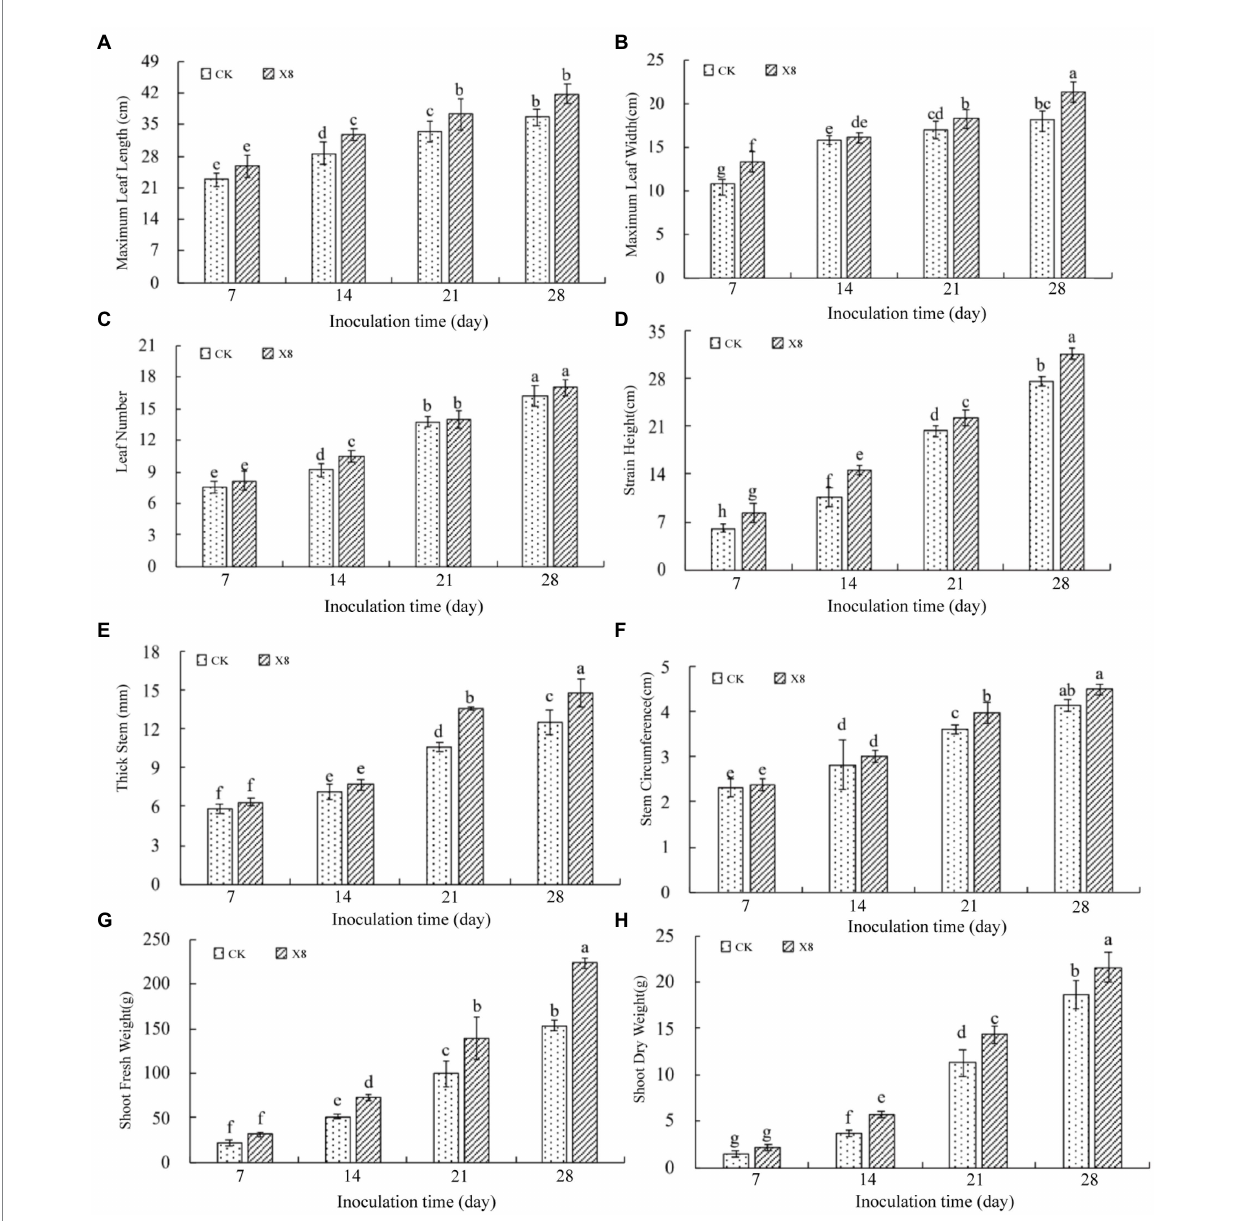
FIGURE 3 Impact of X8 on tobacco growth indicators. The error bars reflect standard error, mean (±SE) ( n = 3). Lowercase letters refer to significant differences (LSD test, p < 0.05). (A) Maximum leaf length, (B) maximum leaf width, (C) number of leaves, (D) plant height, (E) stem thickness, (F) stem circumference, (G) fresh weight, (H) dry